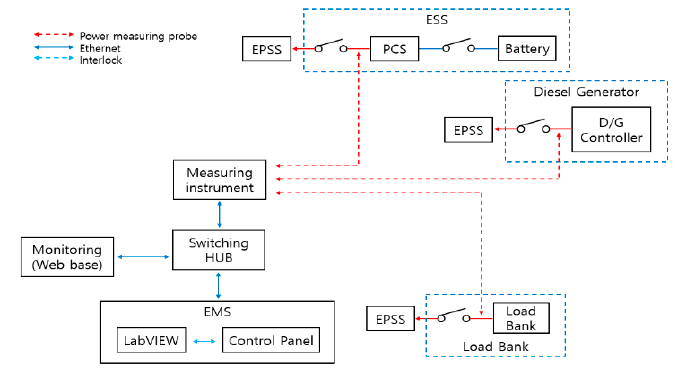
Figure 10. Monitoring system configuration for power quality analysis.